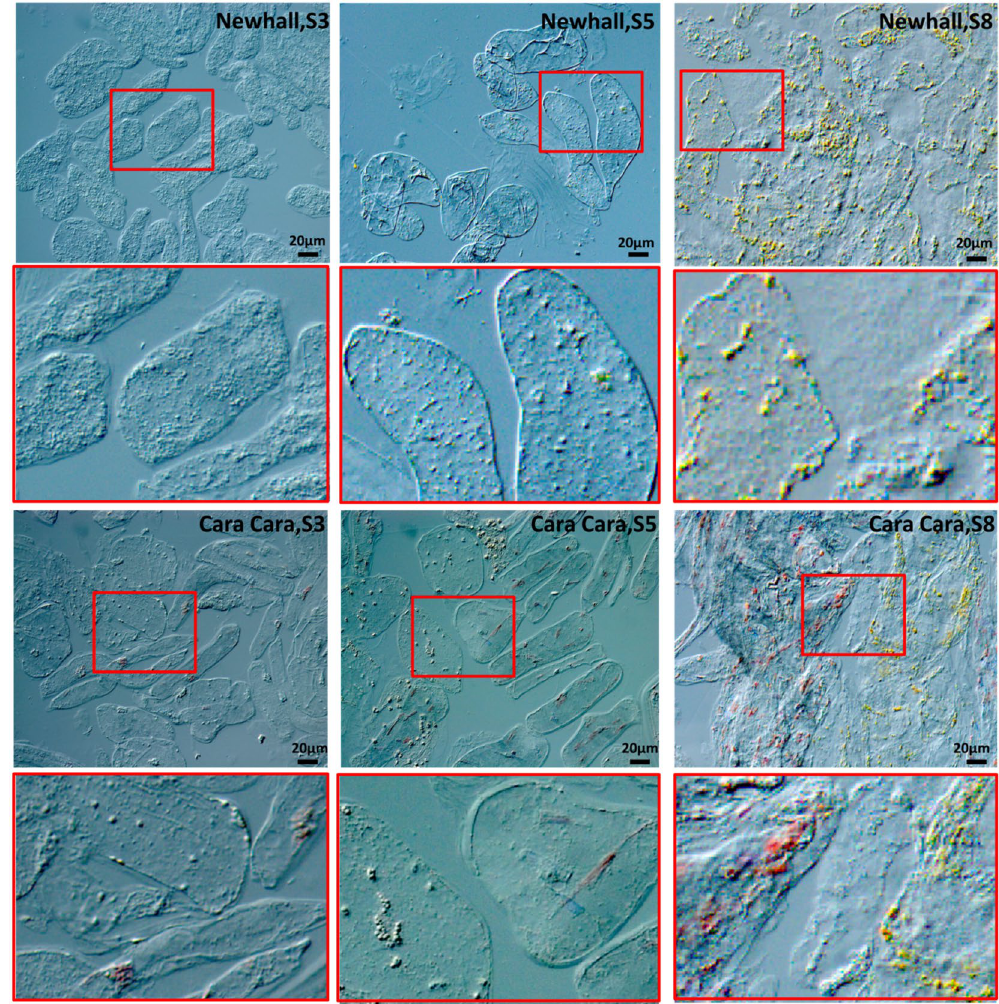
Figure 3. Cells of Newhall and Cara Cara orange flesh at early stage S3, middle stage S5, ripe stage S8 under DIC (differential interference contrast) microscopy. Bar, 20 μ